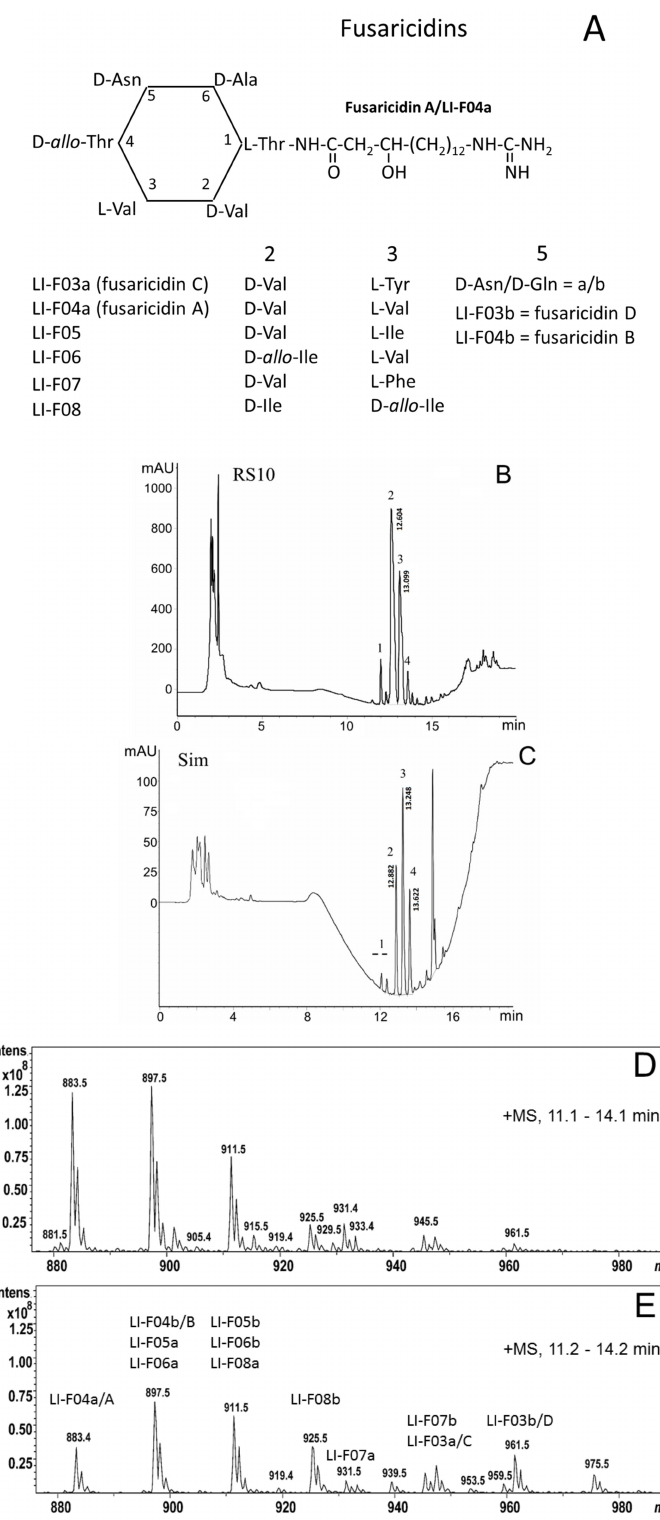
Figure 3. Content of FTCs in RS10 and I / Sim extracts. ( A ) Amino acid substitutions in FTCs. ( B , C ) HPLC fractionation of RS10 ( B ) and I / Sim ethanol extracts ( C ) (10 and 1 µ L, respectively); numbers 1–4 show toxic fractions in the extracts. ( D , E ) Mass spectra of toxic HPLC fractions (range 11–14 min) of RS10 ( D ) and Sim ( E ) extracts. Representative data of at least three runs are